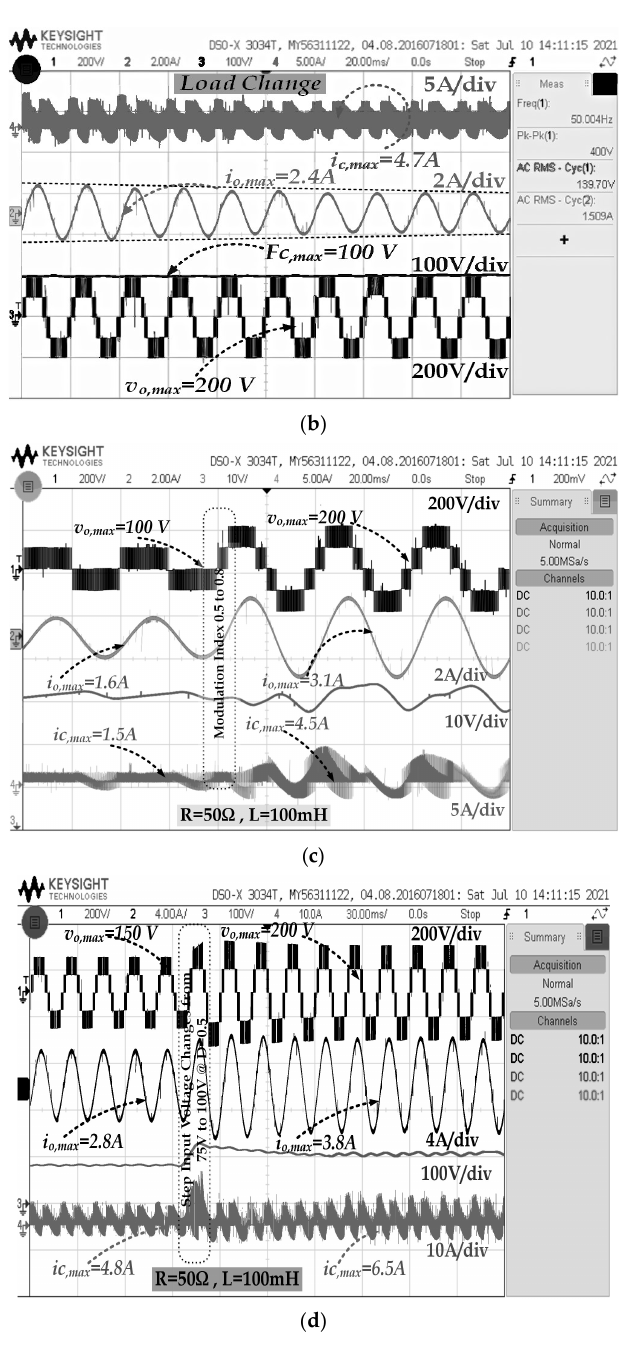
Figure 6. Experimental results of proposed 5L-SBI ( a ) v o , i o and V L , i L , ( b ) output voltage with load change, ( c ) changing of modulation index, and ( d ) step input change. ( v o,max — maximum output voltage, i o,max — maximum output current, i o,max — maximum capacitor current, v L — inductor voltage, FC max — maximum capacitor voltage).